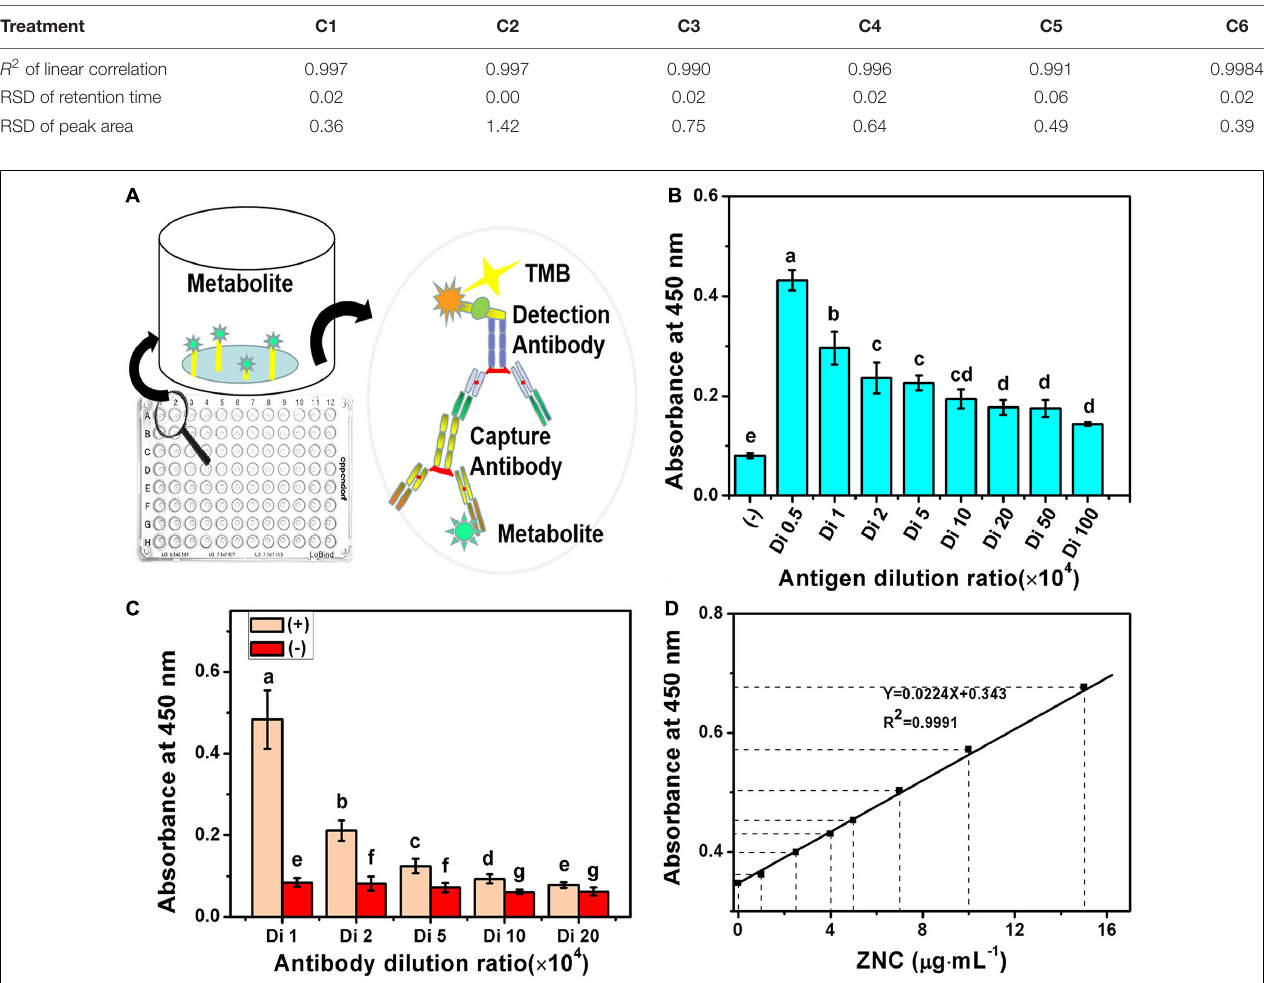
FIGURE 5 | Multiple antibody enzyme-linked immunosorbent assay (MA-ELISA) for ZNC established using indirect-ELISA. (A) Schematic illustration, (B) antigen sensitivity, (C) antibody titer, and (D) linear correlation coefficient of ZNC using MA-ELISA. Note: Means on top of each column followed by the same letter were not significantly different at the 0.05 level based on one-way analysis of variances (ANOVAs) followed by Duncan’s multiple range